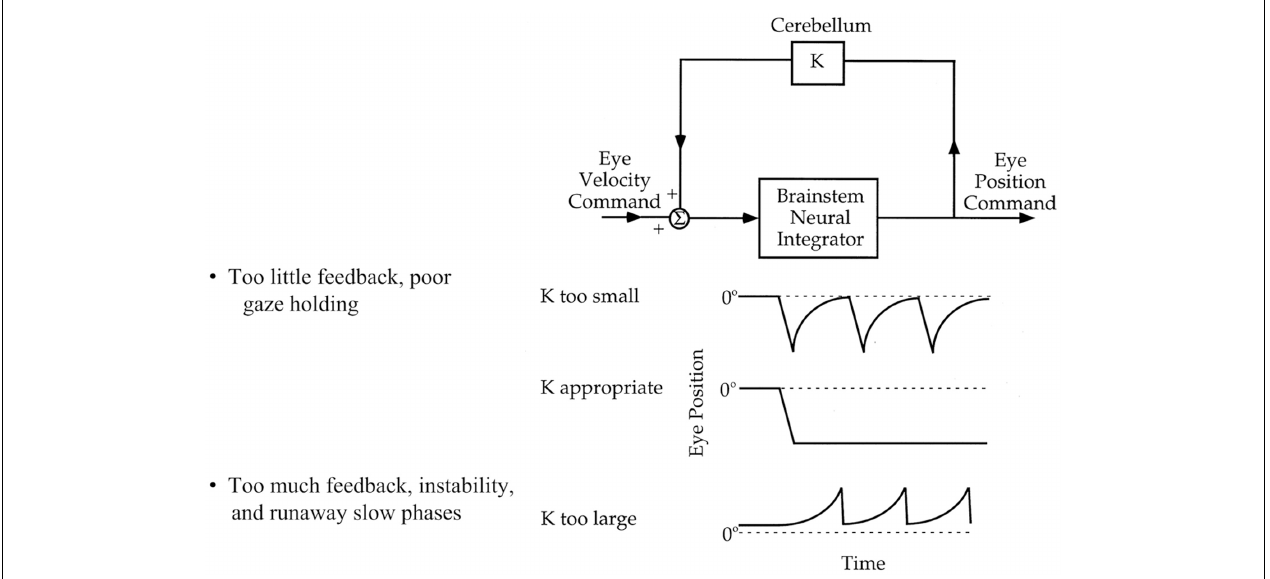
ability of the brain stem neural integrator to generate a steady tonic eye position command. If feedback is inadequate, gaze holding is impaired. If feedback is excessive, gaze is unstable (Zee et al.,